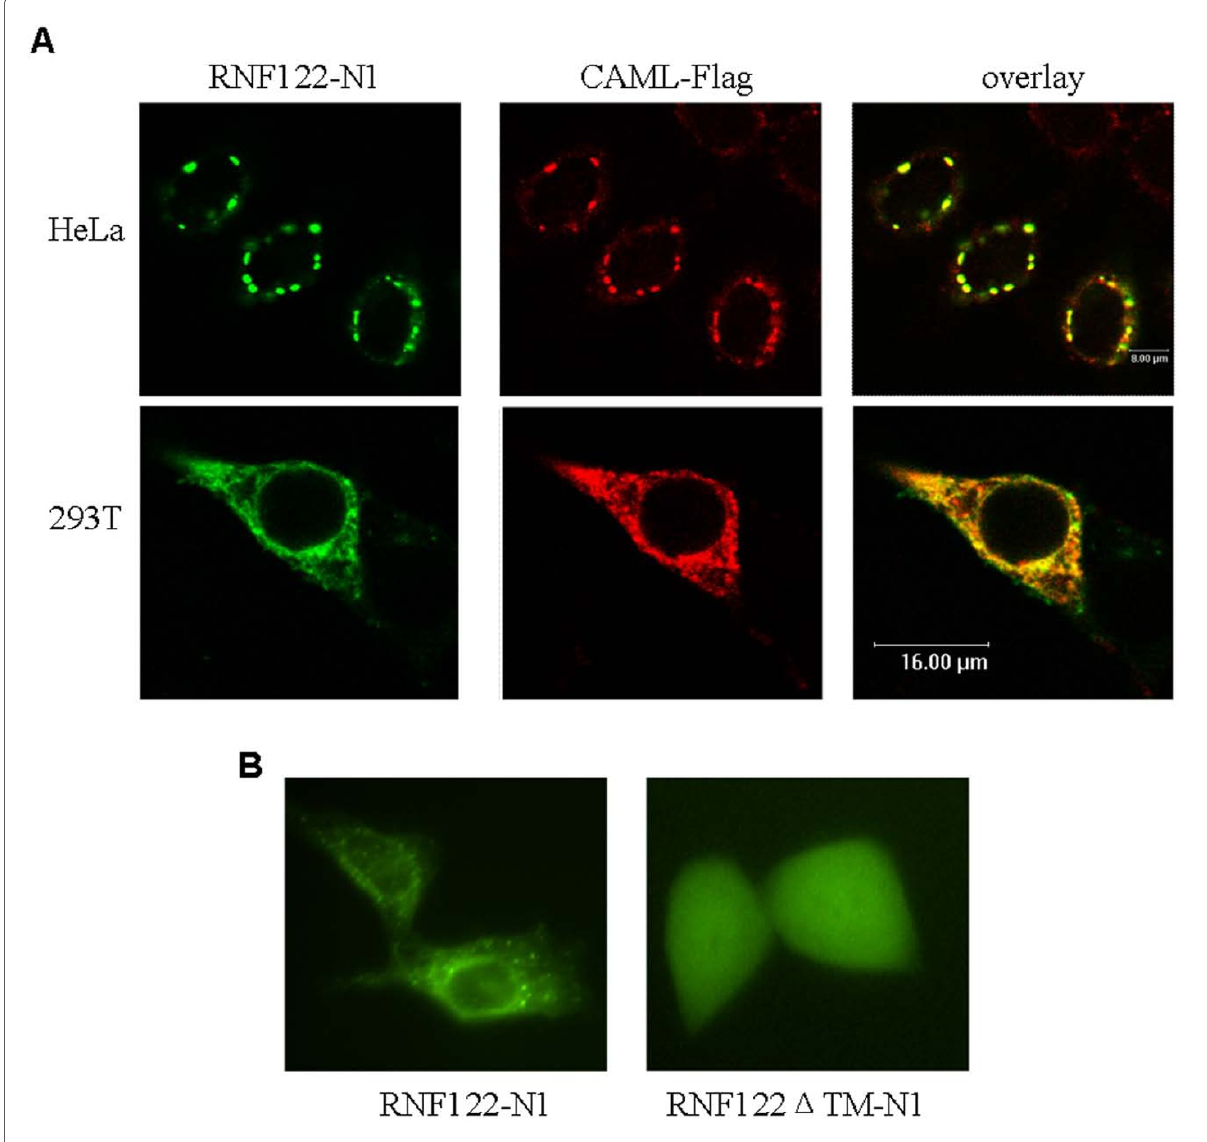
Figure 4 Subcellular localization of RNF122 . (A) HeLa or HEK293T cells were grown on coverslips and transfected with RNF122-N1 and CAML-FLAG. To inhibit the degradation of RNF122-N1, the cells were treated with 2.5 μM MG132 for 6 h. The cells were then treated with anti-FLAG antibody and FITC-conjugated goat anti-mouse antibody, and observed under a confocal microscopy. The results showed that the cytoplasmic distribution of CAML entirely overlapped that of RNF122. (B) HEK293T cells were transfected with RNF122-N1 and RNF122ΔTM-N1 and observed under a fluores- cence